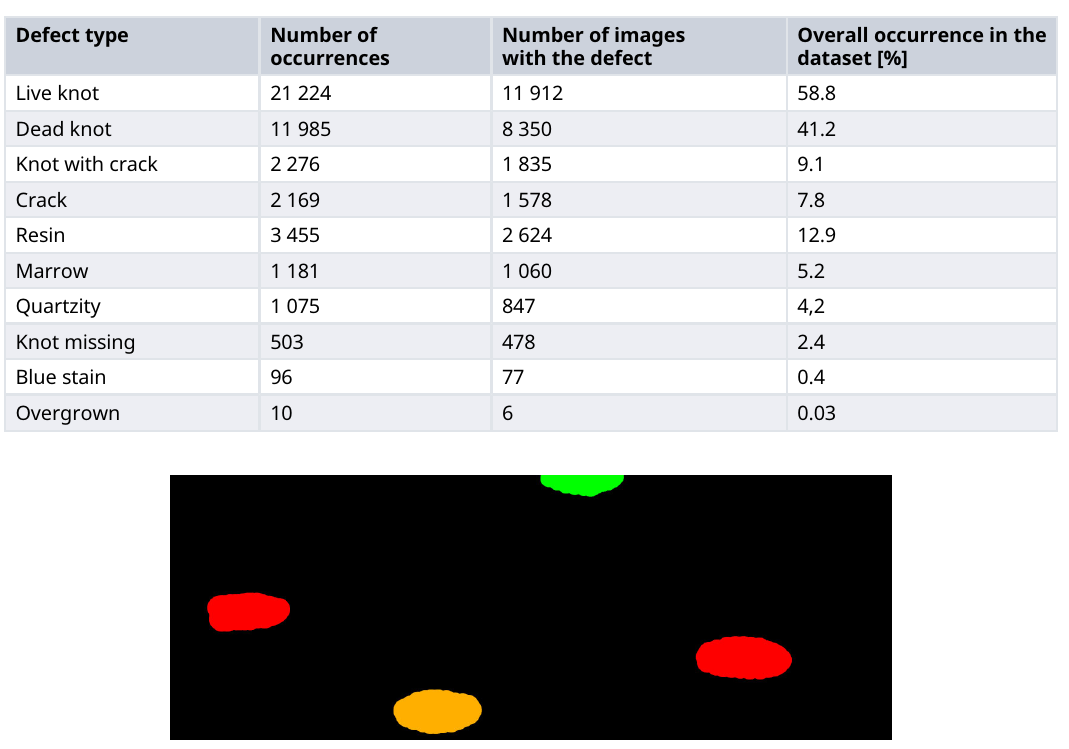
Table 1. Wood surface defects included in the database with the number of particular occurrences and an overall occurrence within the dataset.